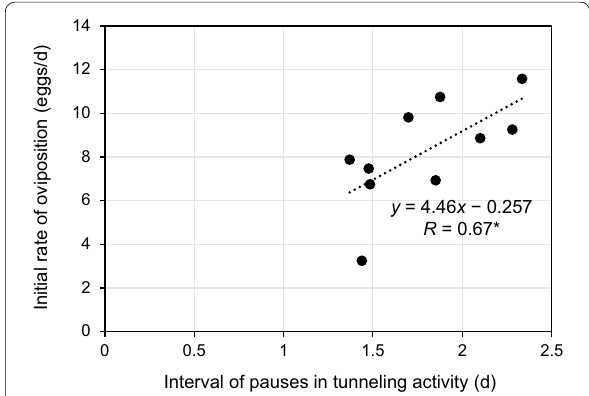
Fig. 9 Relationship between interval of pauses in the tunneling activity of females and initial oviposition rate. (*) correlation significant at 0.05 level